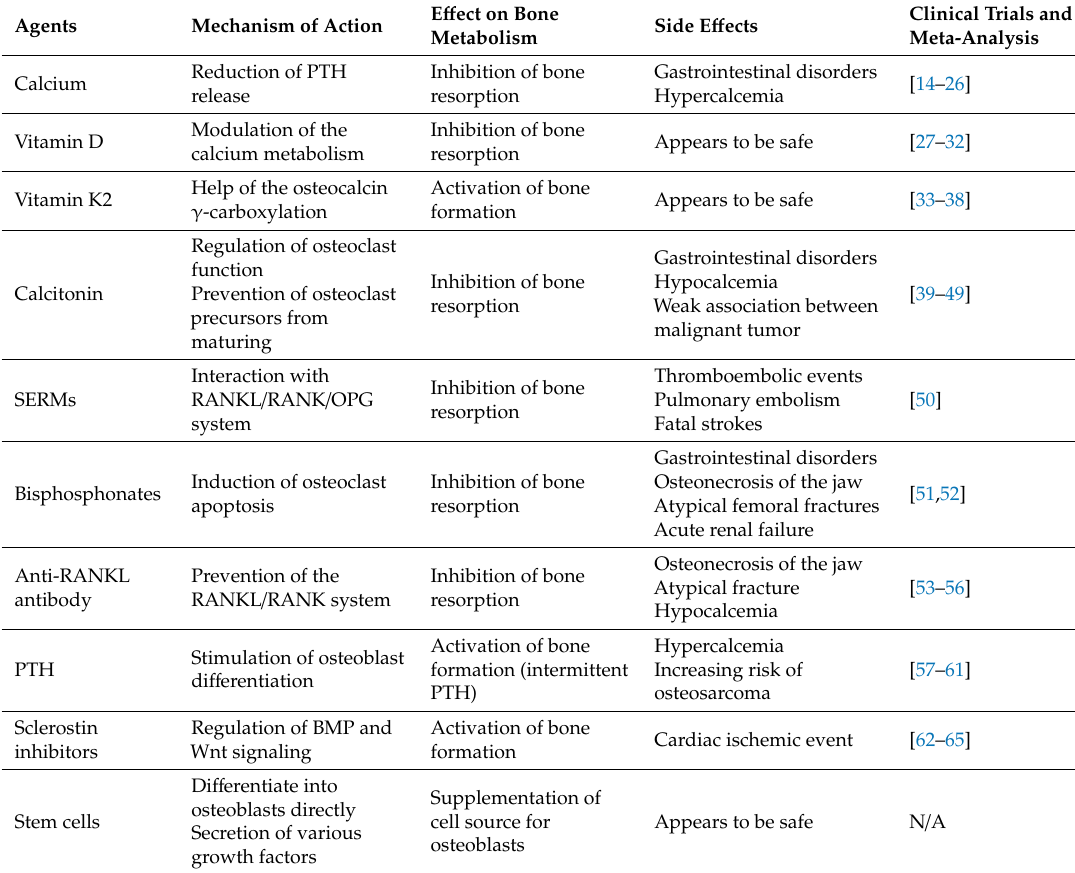
Table 1. Summary of the treatment osteoporosis identified in this